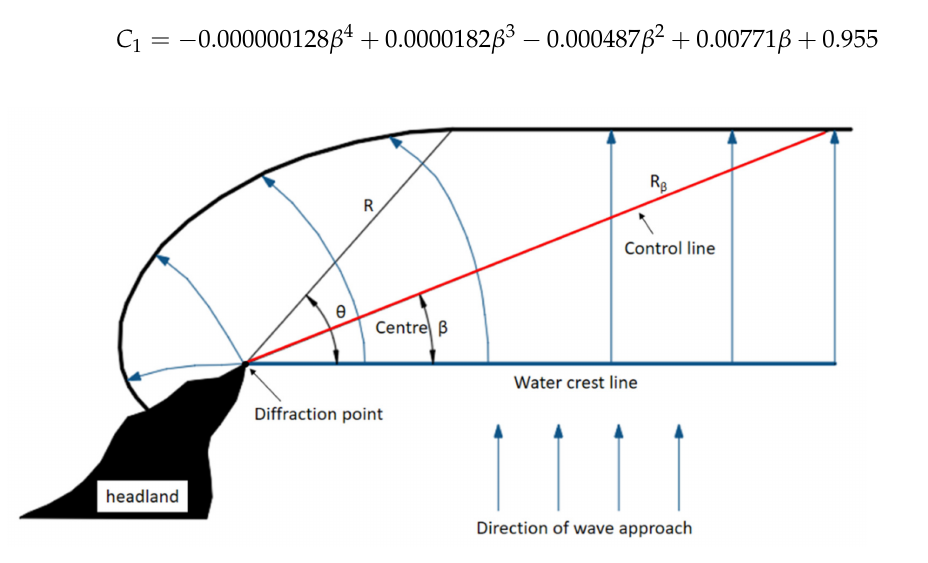
Figure 2. Definition sketch for the parabolic